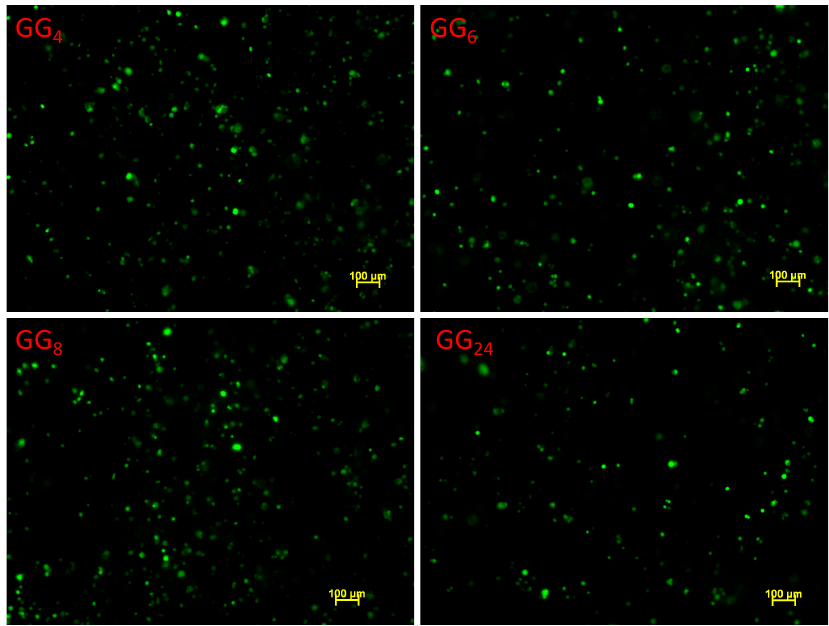
Figure 10. Live/dead staining of MC3T3-E1 preosteoblastic cells encapsulated into GG products after 24 h of culture.